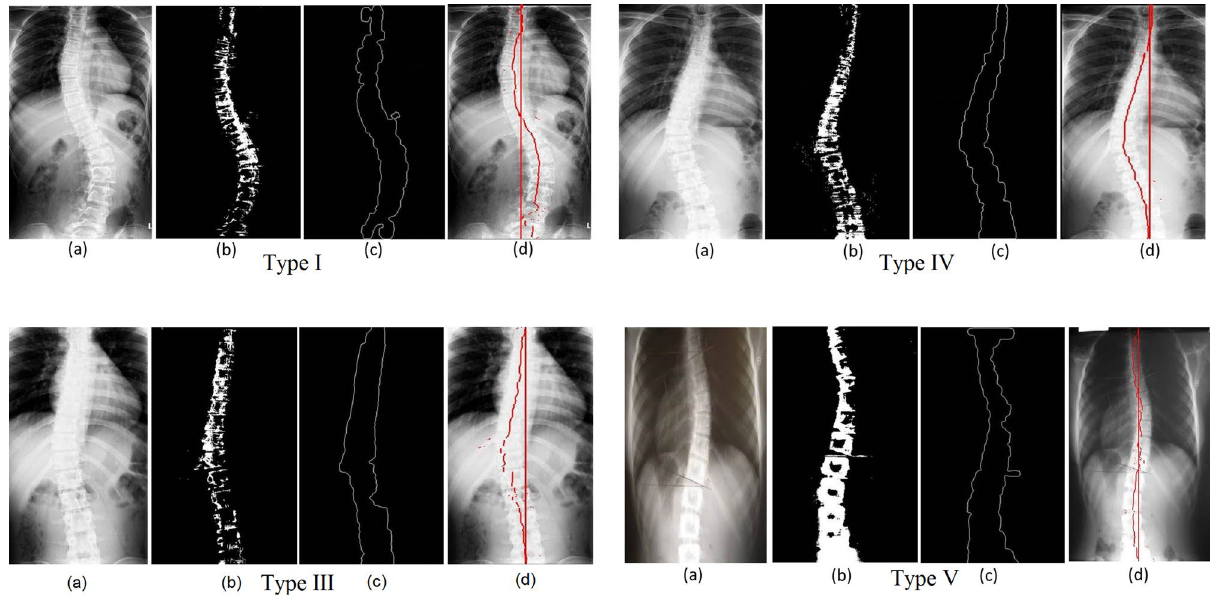
Figure 4. Images of Type-I, Type-III, Type-IV and Type-V for ( a ) input radiograph, ( b ) segmented vertebral column, ( c ) extracted boundary and ( d ) automated definition of MA and